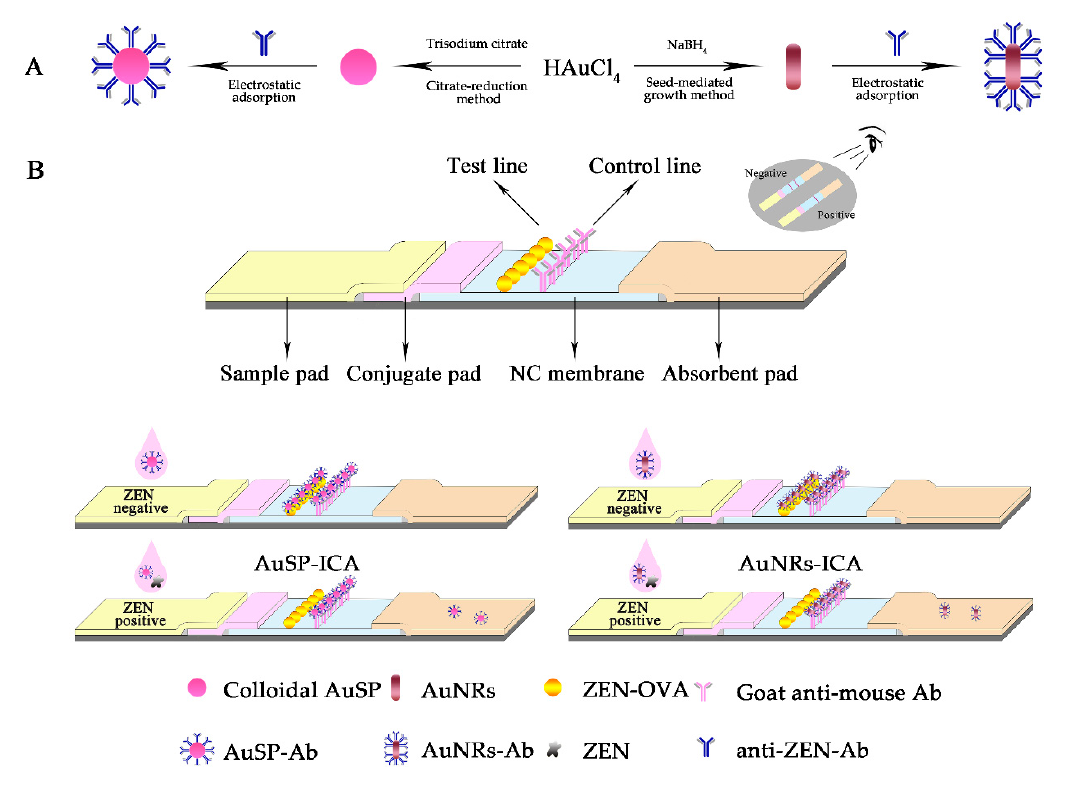
Figure 1. Schematic of AuSP-ICA and AuNRs-ICA. ( A ) The synthesis of AuSP and AuNRs and the coupling process with anti-ZEN-Ab; ( B ) structure of the immunochromatographic assay (ICA) strip and the test procedure for the ICAs.